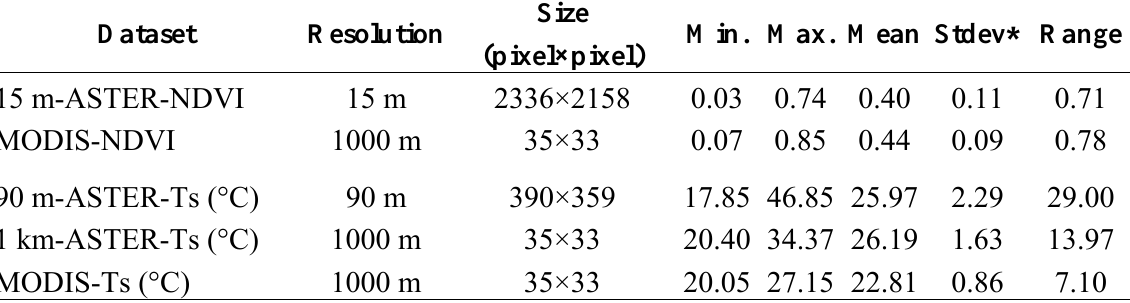
Table 1. Statistics of the ASTER and MODIS datasets of Ts and NDVI on May 9 2003.